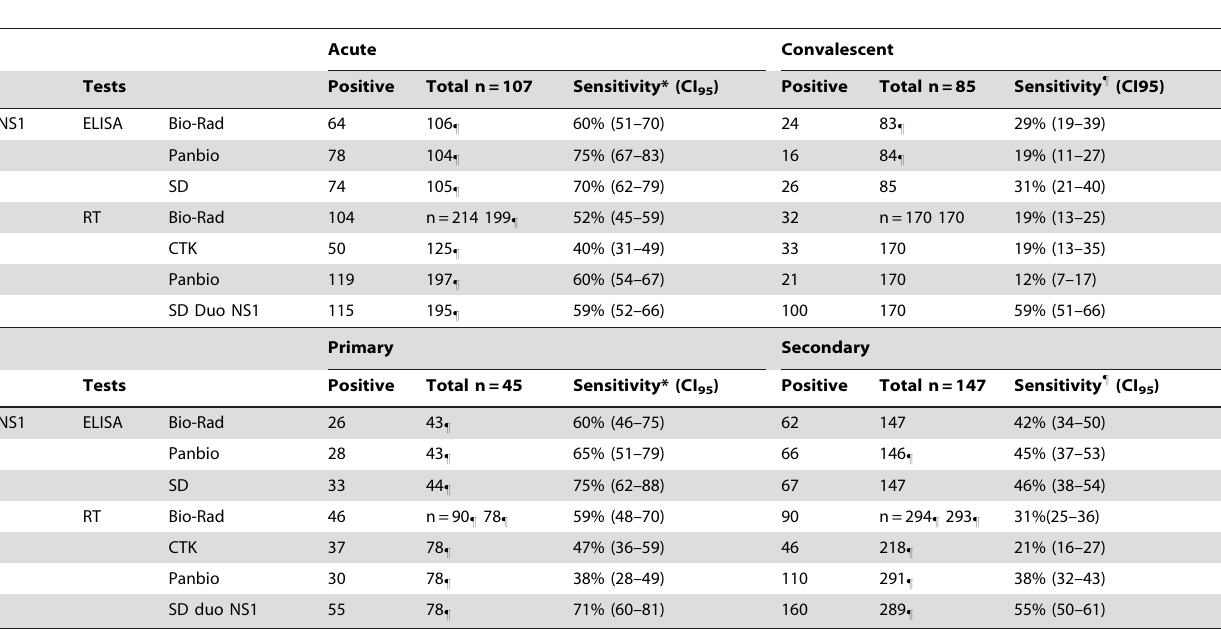
Table 5. Sensitivity of DENV NS1 antigen compared to RT-PCR and/or virus isolation in acute and positive rate of the convalescent